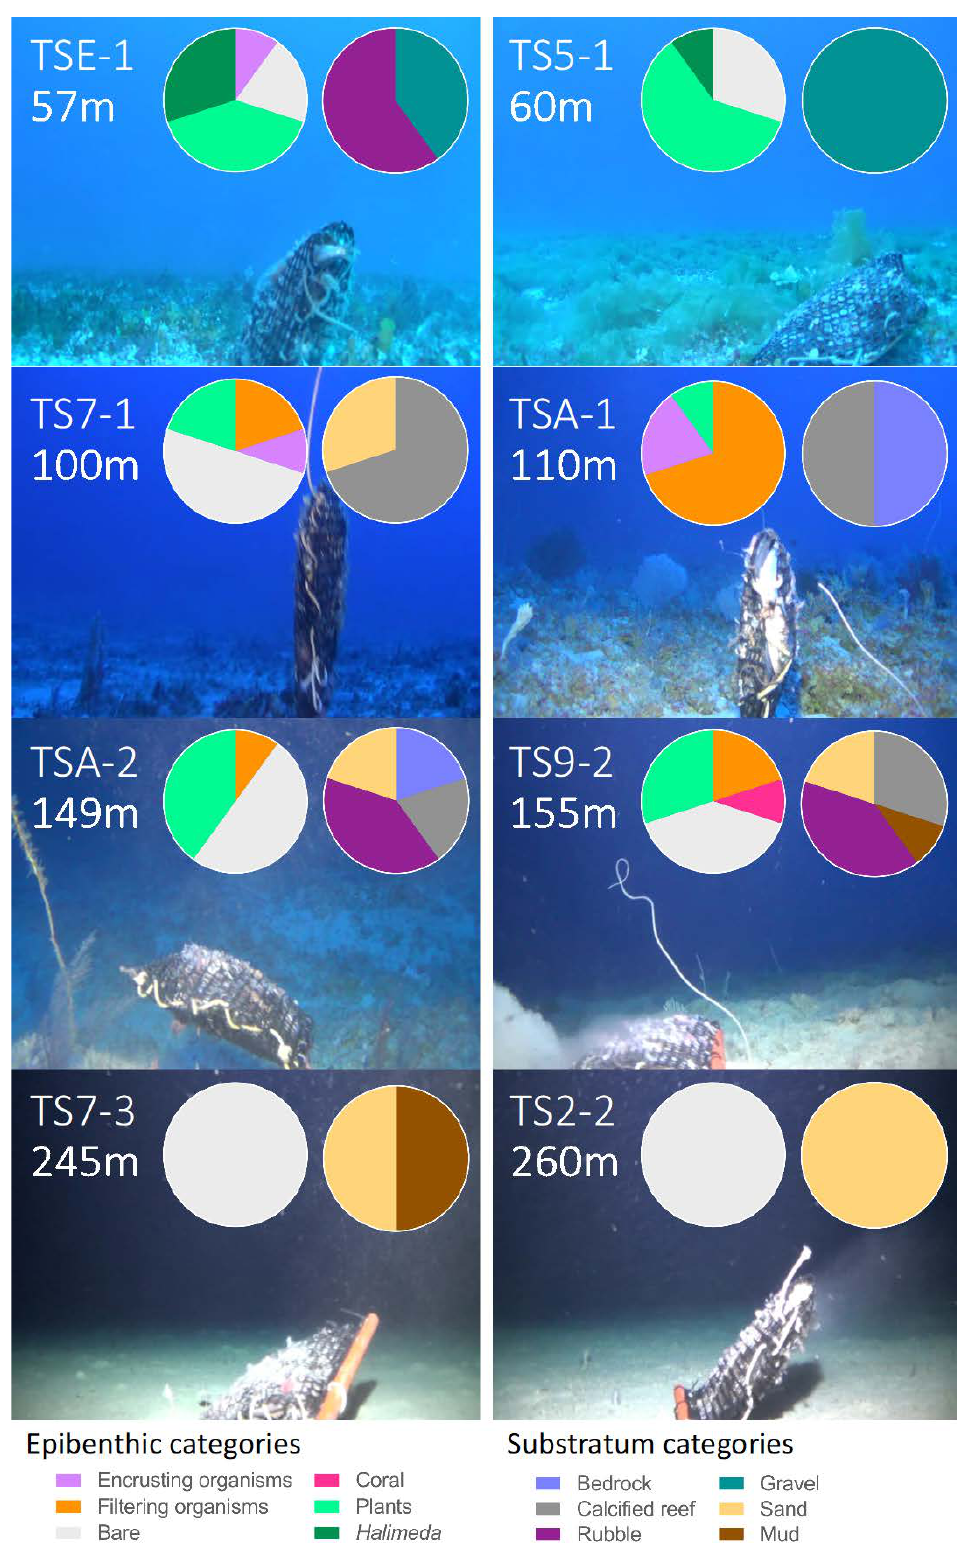
Figure 4. Examples of deep-reef habitats from the field-of-view of Baited Remote Underwater Video Stations (BRUVS). The bait arm extension is visible in the video frame. A unique BRUVS operation code (TS_ removed observer bias) and depth are noted for each site with the relative proportion of epibenthic (left pie chart) and substratum categories (right pie chart).